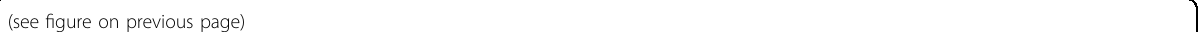
Fig. 5 Genetic inactivation of RIP1 kinase activity reduces plasma NfL and additional markers of injury following ischemic brain injury. A Plasma NfL levels in WT and RIP1 KD rats before and 2-, 15-, and 30-days after sham or tMCAO surgery. n = 8 – 10 rats/group. At the indicated time points, ** p < 0.01 between WT-tMCAO and WT-Sham (in gray), and * p < 0.05 and p = 0.07 between RIP1 KD-tMCAO and WT-tMCAO (in black) by Two-way ANOVA (Holm-Sidak). Data are represented as mean ± S.E.M. B Correlation between plasma NfL levels at 2 days versus 20-point neuroscore at 3 (open circles) and 28 days (closed circles) post-tMCAO, from ( A ) and Fig. 2C. * p < 0.05 by Spearman test. C Plasma protein pro fi ling by mass spectrometry in WT and RIP1 KD rats before and 2-, 15-, and 30-days after sham or tMCAO surgery. n = 10 rats/group. Each graph represents log2 fold-change in plasma protein abundance at the indicated time points, post-surgery compared to pre-surgery, in WT ( x -axes) and RIP1 KD ( y -axes) rats. Proteins that show signi fi cant difference in abundance upon sham surgery in WT animals (>1.2 fold-change, adjusted p -value < 0.1, open symbols in Supplementary Fig. 3B) are excluded from the graphs. Symbol colors represent changes in plasma protein abundance according to the genotypes such that blue symbols represent signi fi cant change in both WT and RIP1 KD plasma, red symbols represent signi fi cant change only in WT plasma, and gray symbols represent no signi fi cant change in WT plasma. D Graphs representing the log2 fold-change in plasma protein abundance of the indicated proteins compared to baseline levels in WT and RIP1 KD rats. Symbol colors represent WT or RIP1 KD rats. Symbol types, closed or open, represent statistical signi fi cance as indicated. Error bars represent standard error of the log2 fold